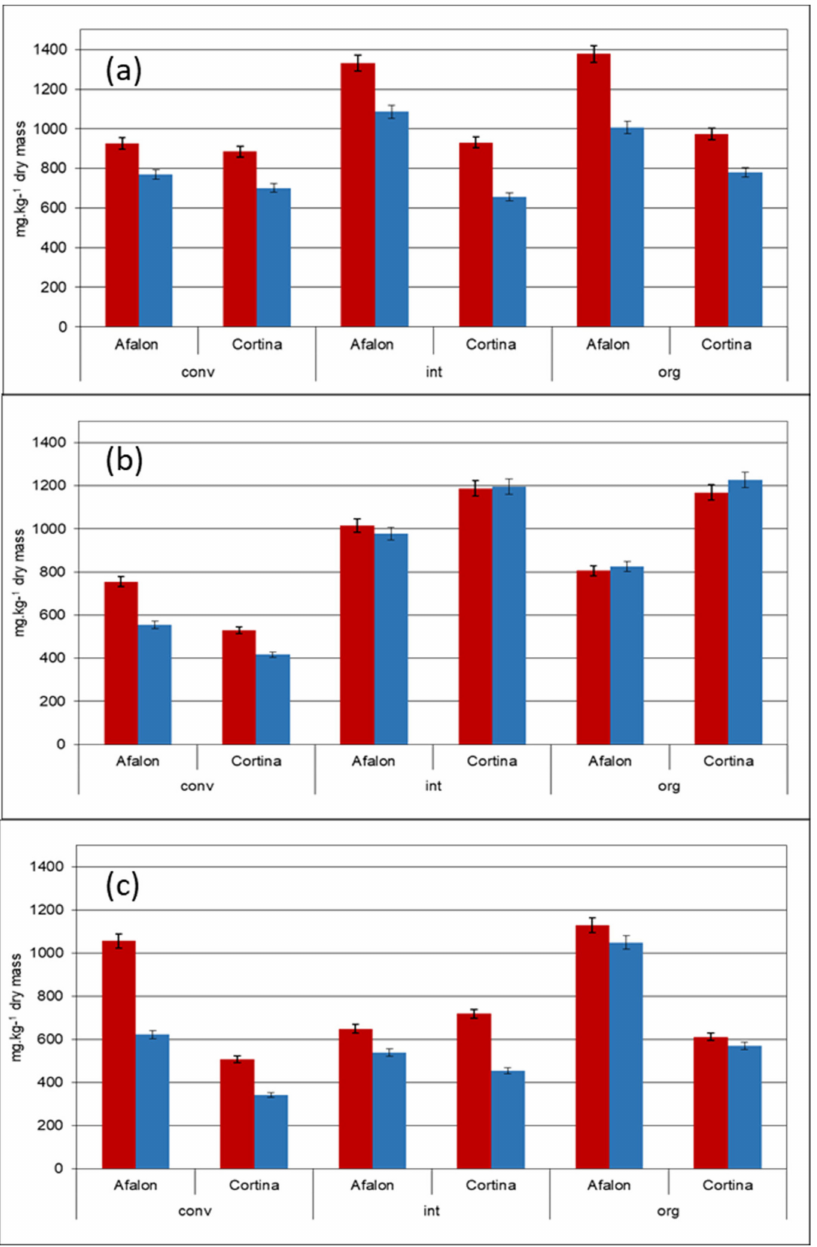
Figure 2. Comparison of β -carotene and α -carotene content in Cortina and Afalon grown in con- ventional (conv), integrated (int) and organic (org) systems: ( a ) crop year 2012, seeding density 9 × 10 5 seeds ha − 1 ; ( b ) crop year 2013, seeding density 6 × 10 5 seeds ha − 1 ; ( c ) crop year 2013, seeding density 9 × 10 5 seeds ha − 1 . The content of carotenes is expressed in mg per kg dry weight; β -carotene, red; α -carotene,